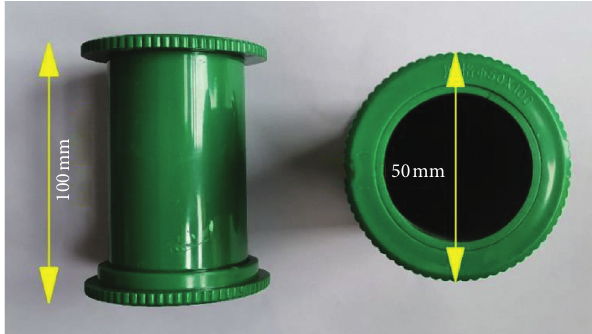
Figure 6: Mould size.